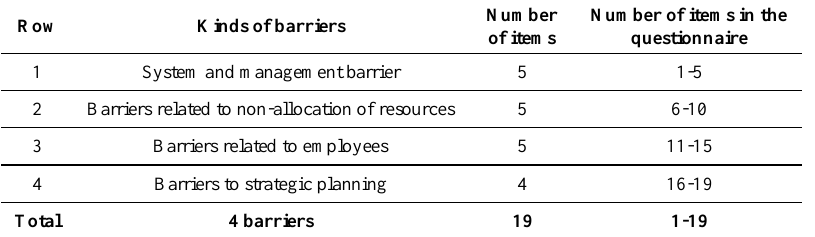
Number Number of items in the of items questionnaire